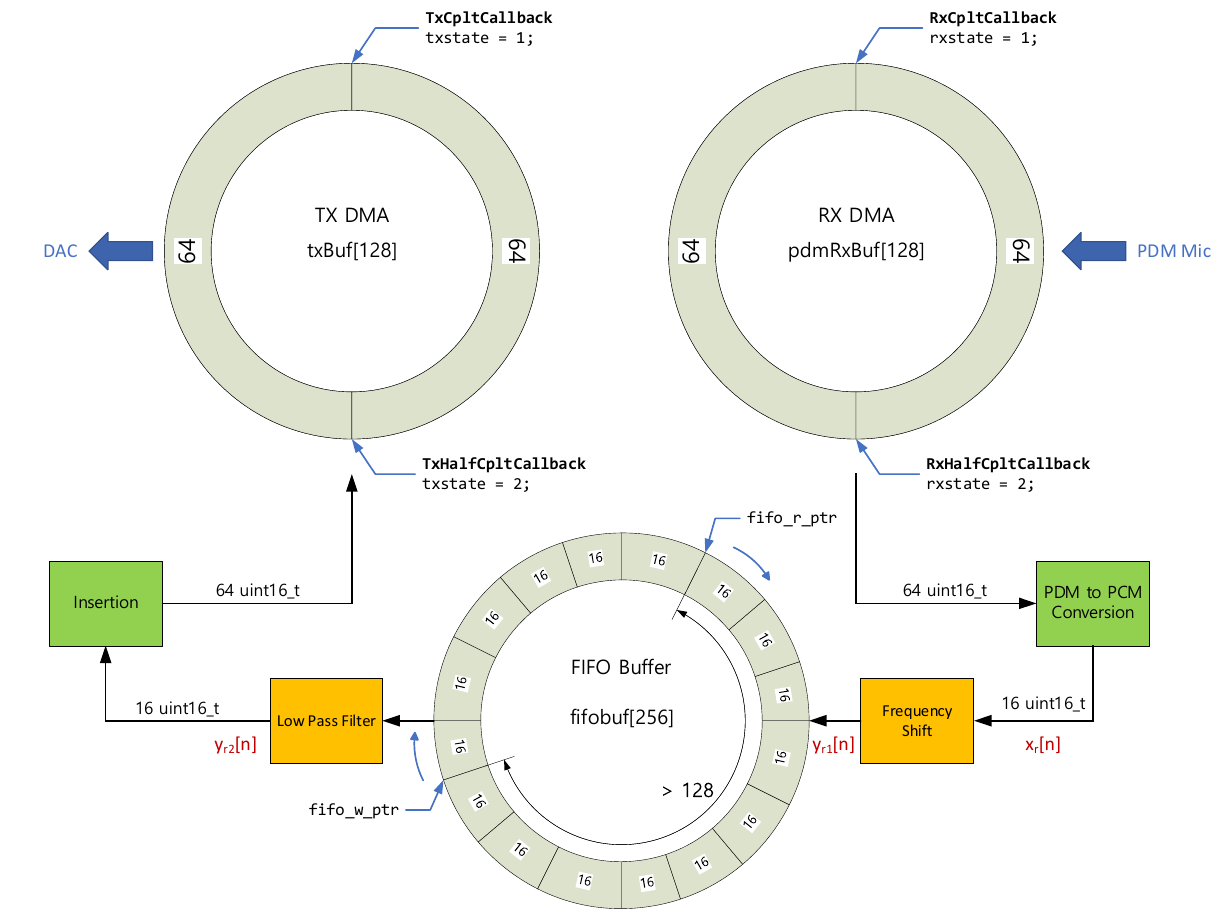
Figure 13. Software structure for the receiver realization.